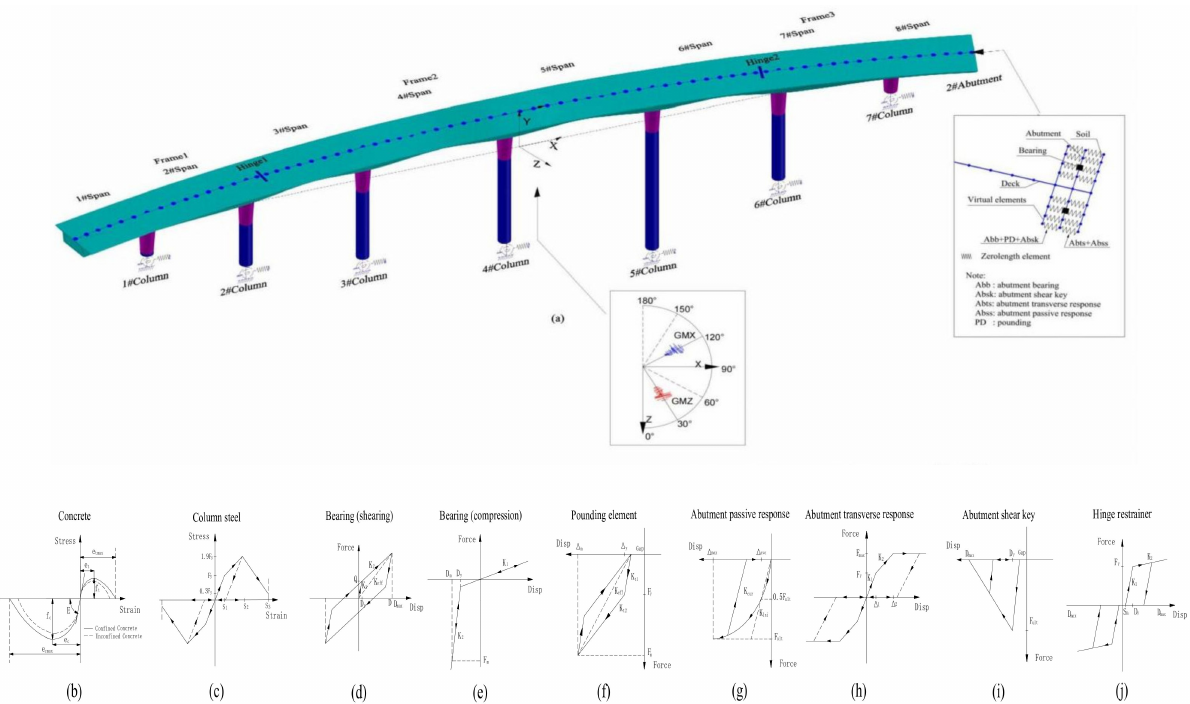
Figure 2. Numerical model: ( a ) entire bridge; ( b ) confined and unconfined concrete; ( c ) longitudi- nal reinforcement in column; ( d ) bearing (shearing direction); ( e ) bearing (compression direction); ( f ) pounding; ( g ) abutment passive performance; ( h ) abutment transverse response; ( i ) shear key; ( j ) hinge longitudinal